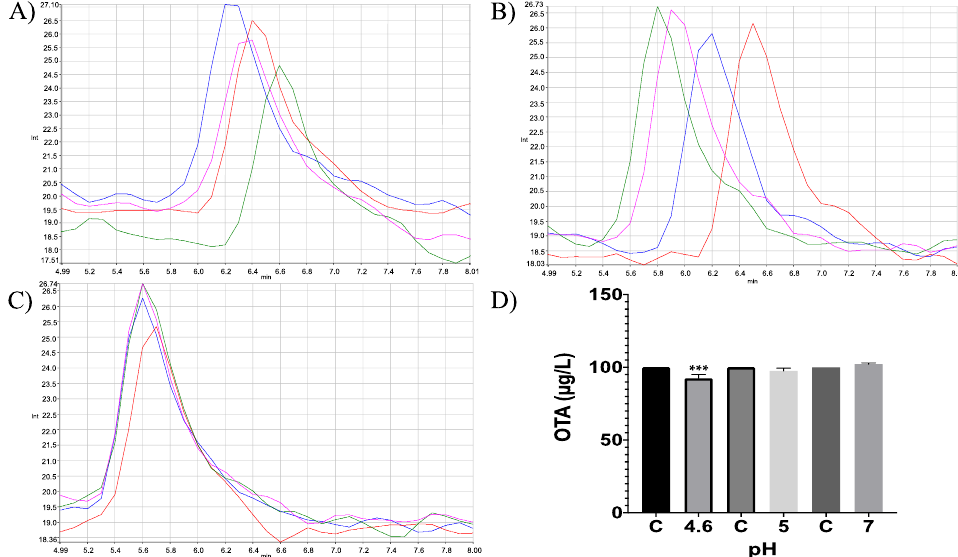
Figure 7. HPLC- fluorescence chromatograms of bromelain -OTA in vitro experiments showing differences in bromelain’s capacity to hydrolyse OTA at different pH conditions and incubated at 41 °C. ( A ) pH 4.6; ( B ). pH 5; ( C ) pH 7; ( D ) Bars show OTA (µg/L) degradation (7.64%) by bromelain at pH 4.6. In all chromatograms control is represented in red and experimental repetitions are in blue, green and pink. (*** p < 0.0001).